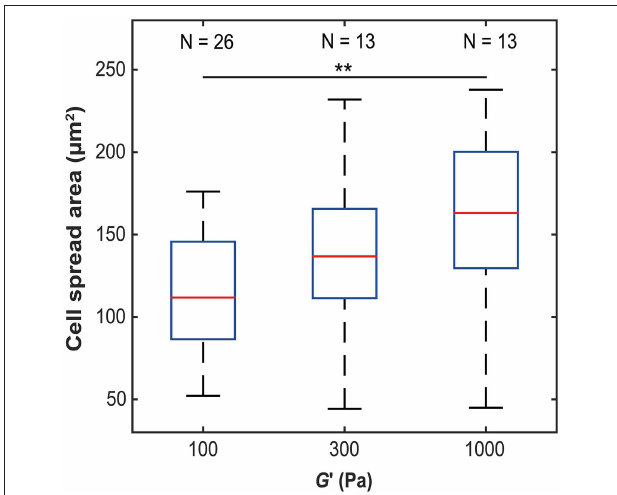
FIGURE 1 | Microglia spread area as a function of substrate stiffness. The spread area of microglial cells significantly increased with substrate stiffness ( p < 0 . 05 , Kruskal-Wallis ANOVA; for G ′ ∼ 100 Pa vs. 1 kPa, p < 0 . 01 , Mann-Whitney U -test). ** p < 0 . 01